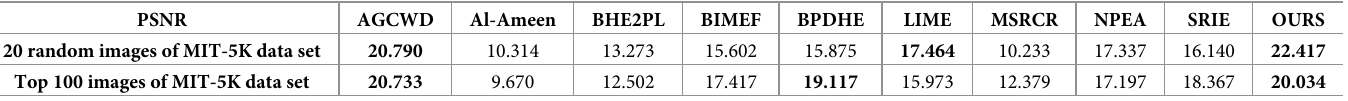
Table 4. Average PSNR of two groups of images of